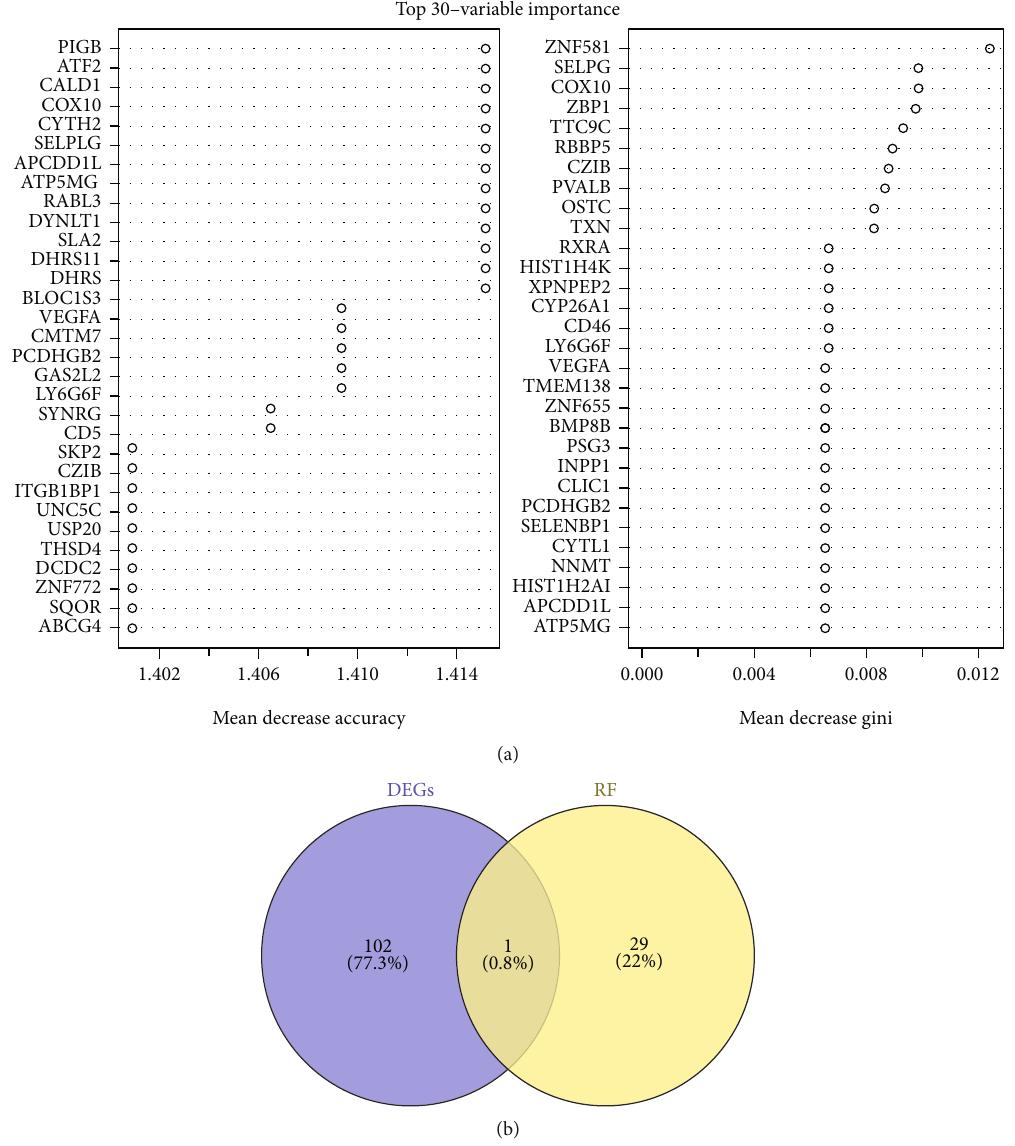
Figure 5: Results of RF model screening. (a) Top 30 genes obtained by RF model analysis. (b) Venn diagram of intersection between hubmRNAs and RF top 30